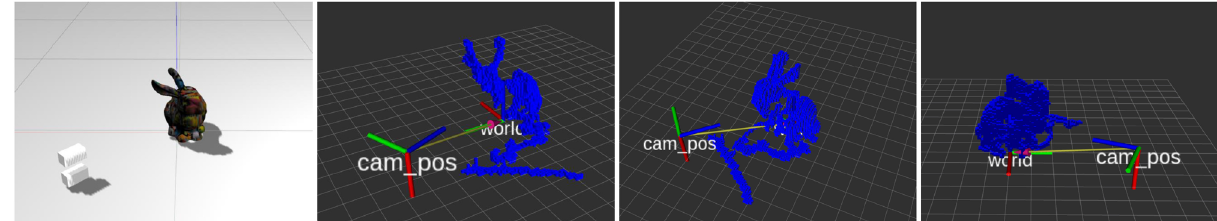
Fig. 7 Simulated active reconstruction. Left: camera and object model. Other images show the process of